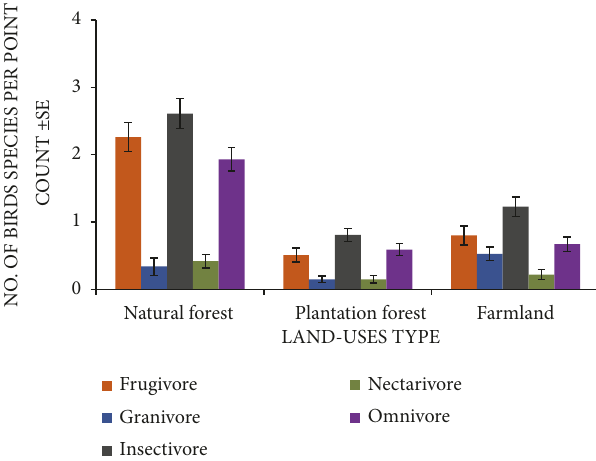
Figure 4: Influence of land-use type on relative richness of avian feeding